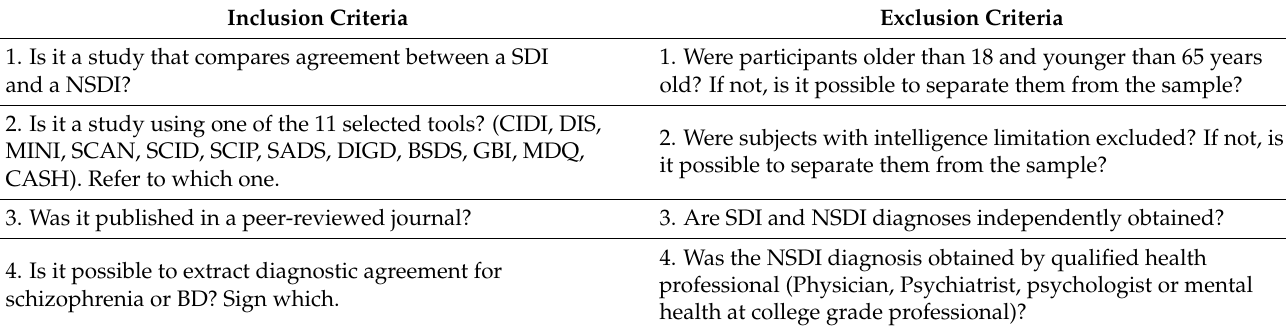
Table 1. Inclusion and Exclusion